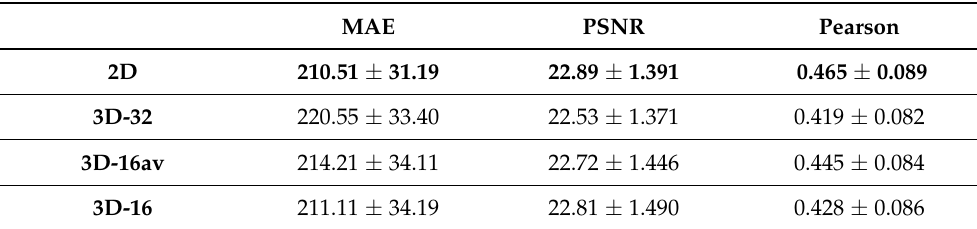
Table 20. Pelvis dataset Bone with Atrous-net. Mean Absolute Error, PSNR and Pearson coefficient from Atrous-net using different convolutions and reconstructions in the Pelvis data set within the bone.